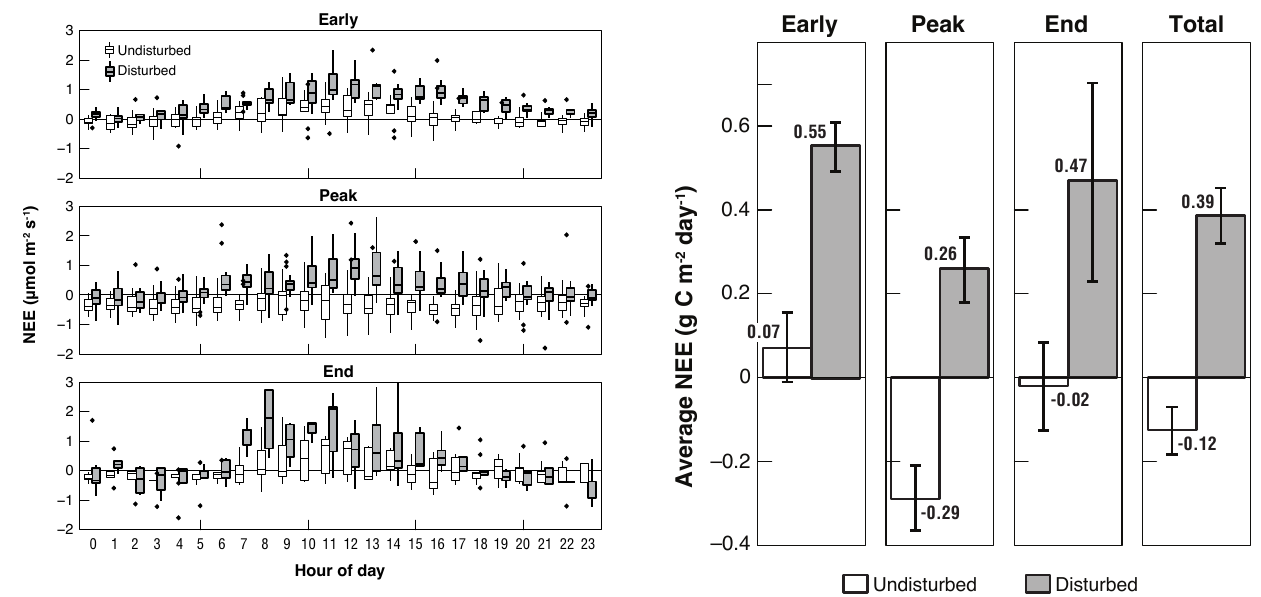
Figure 6. Average daily net CO 2 flux for the three sampling periods as measured by the two EC systems and the net effect for the entire